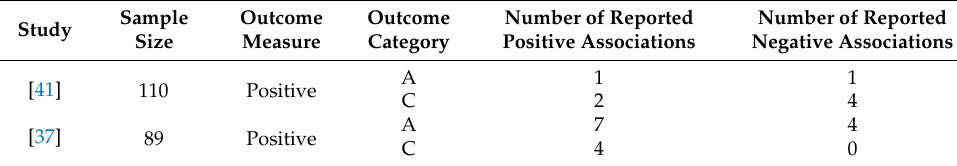
Table 6. Puzzle play—outcome measure descriptions and results